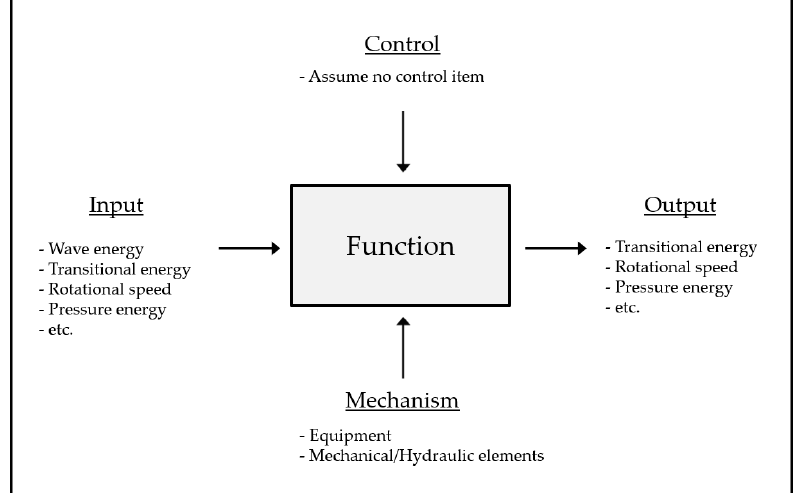
Figure 3. IDEF0 basic formalism.